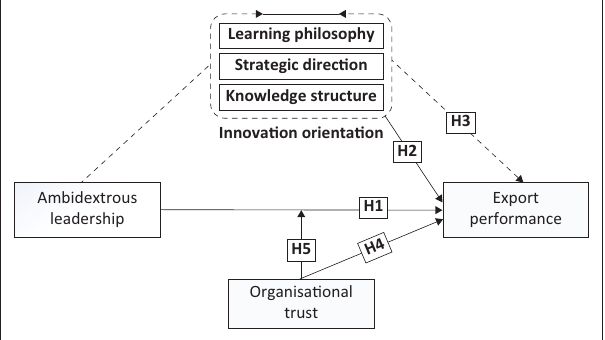
FIGURE 1: Conceptual model on ambidextrous leadership, innovation orientation and export performance: Moderating role of organization